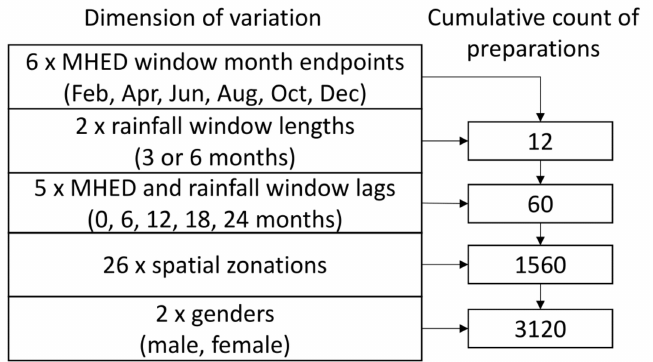
Figure 2. Summarized count of data preparations based on variations in time, space and